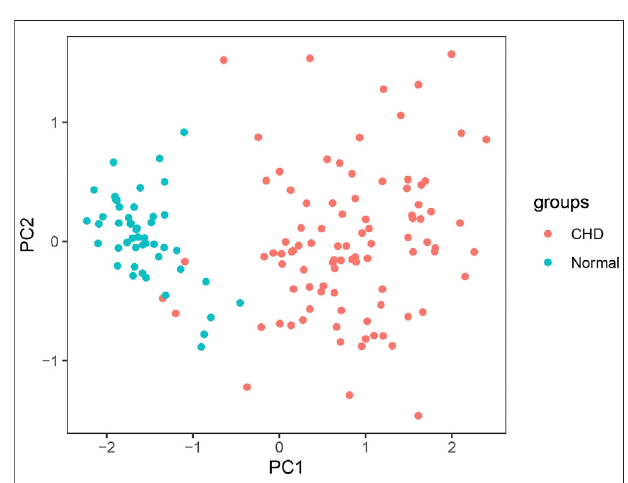
FIGURE 8 | PCA of AC010082.1 and AC011443.1. Red dots represent patients with CHD and light blue dots represent healthy